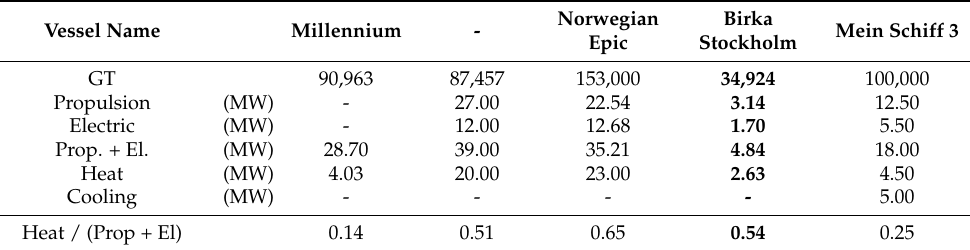
Table 3. Onboard energy demands on cruise ships: Millennium [4], Model from Douglas